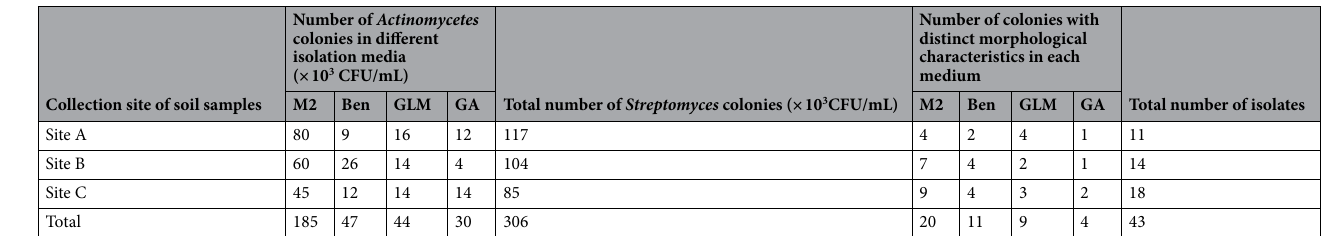
Table 2. Total number of Streptomyces isolates obtained from the three studied sites (A, B and C) according to the culture media used. Site A (SebtJ ahjouh El Hajeb); Site B (Forest of Ain Vittel Ifrane); and Site C (Forest